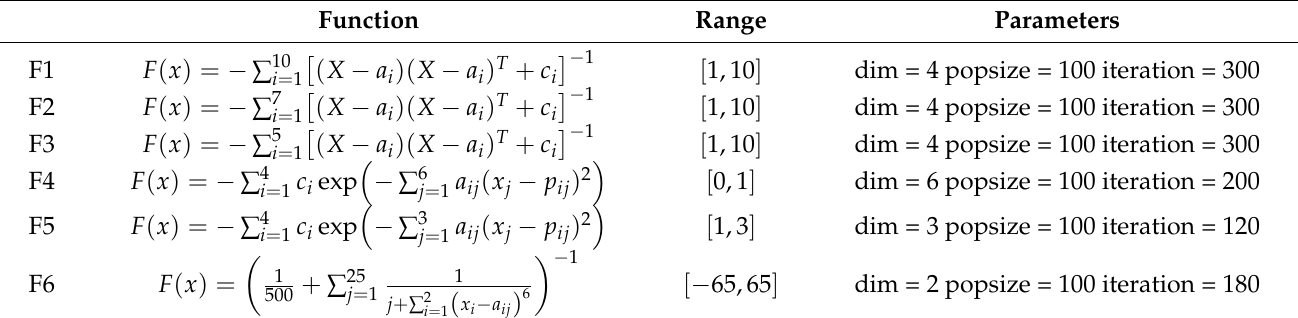
Table 3. Benchmark functions.